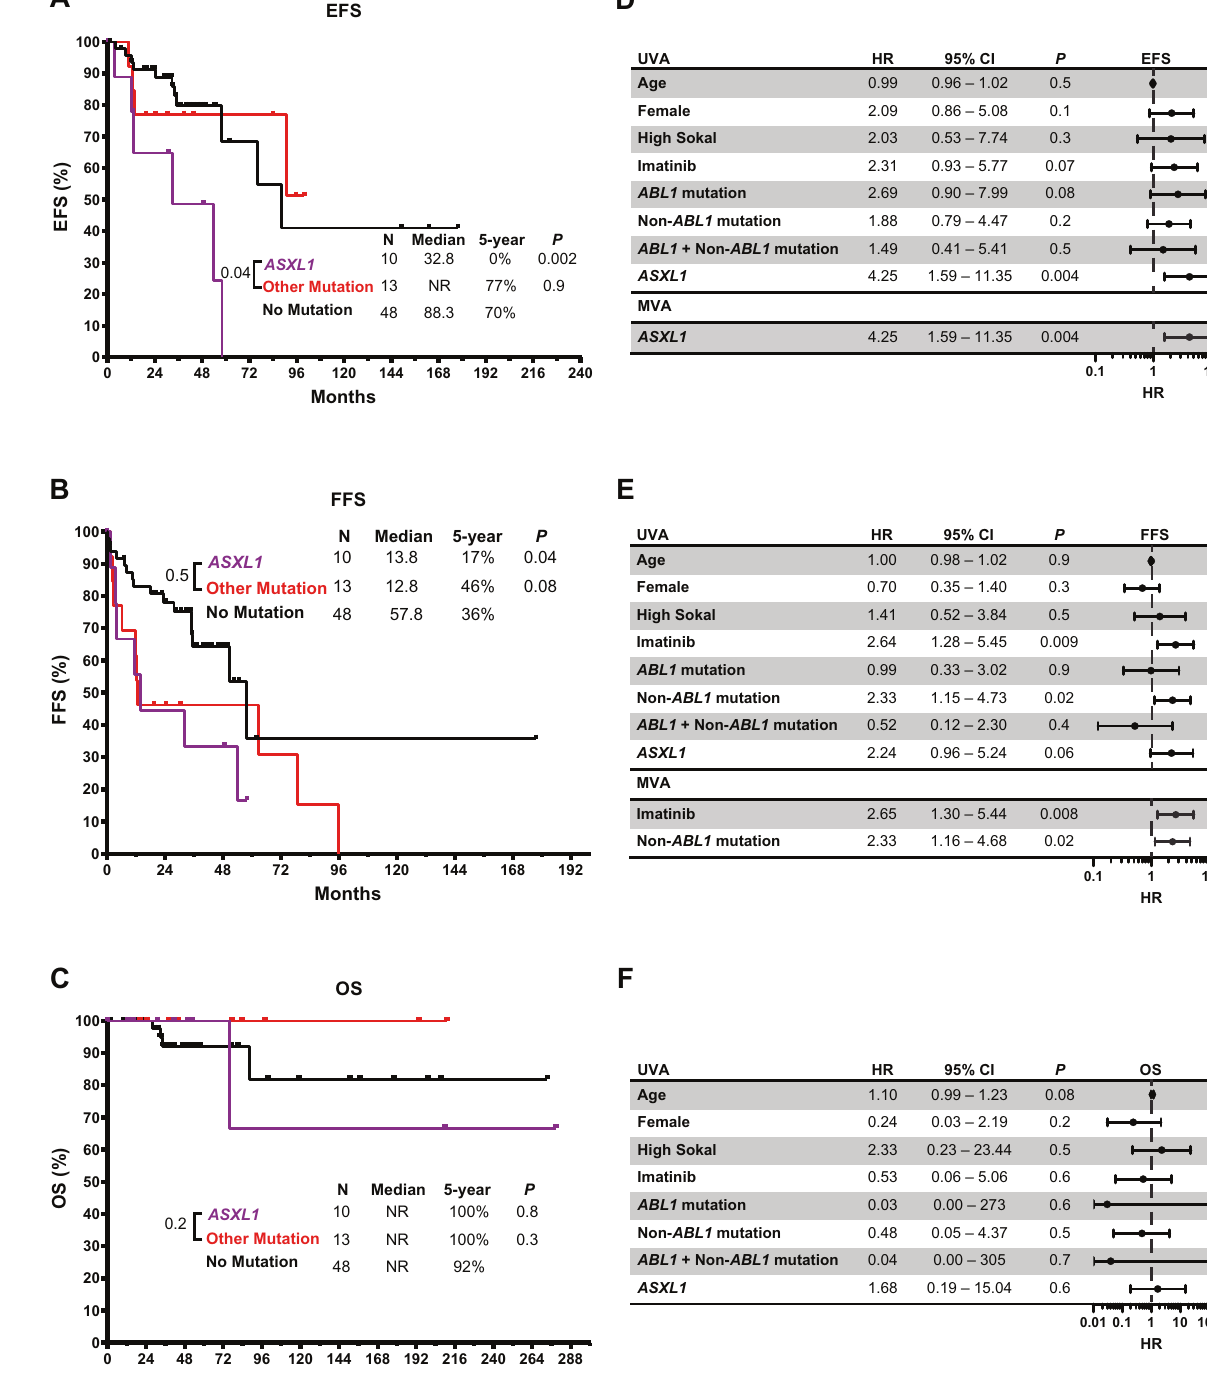
non- ABL1 mutation (Fig. 3A). The most common mutation was ASXL1 detected in 6 (40%) patients followed by RAS, SF3B1, and TET2 detected in 2 (13%) patients each. Mutations were also detected in 7 other non- ABL1 genes as highlighted in (Fig. 3A). ABL1 was the most common mutation in BP-CML, detected in 11 (38%) patients. Sixteen (56%) patients had at least one non- ABL1 mutation and 9 (31%) had two or more mutations (Fig. 3B).